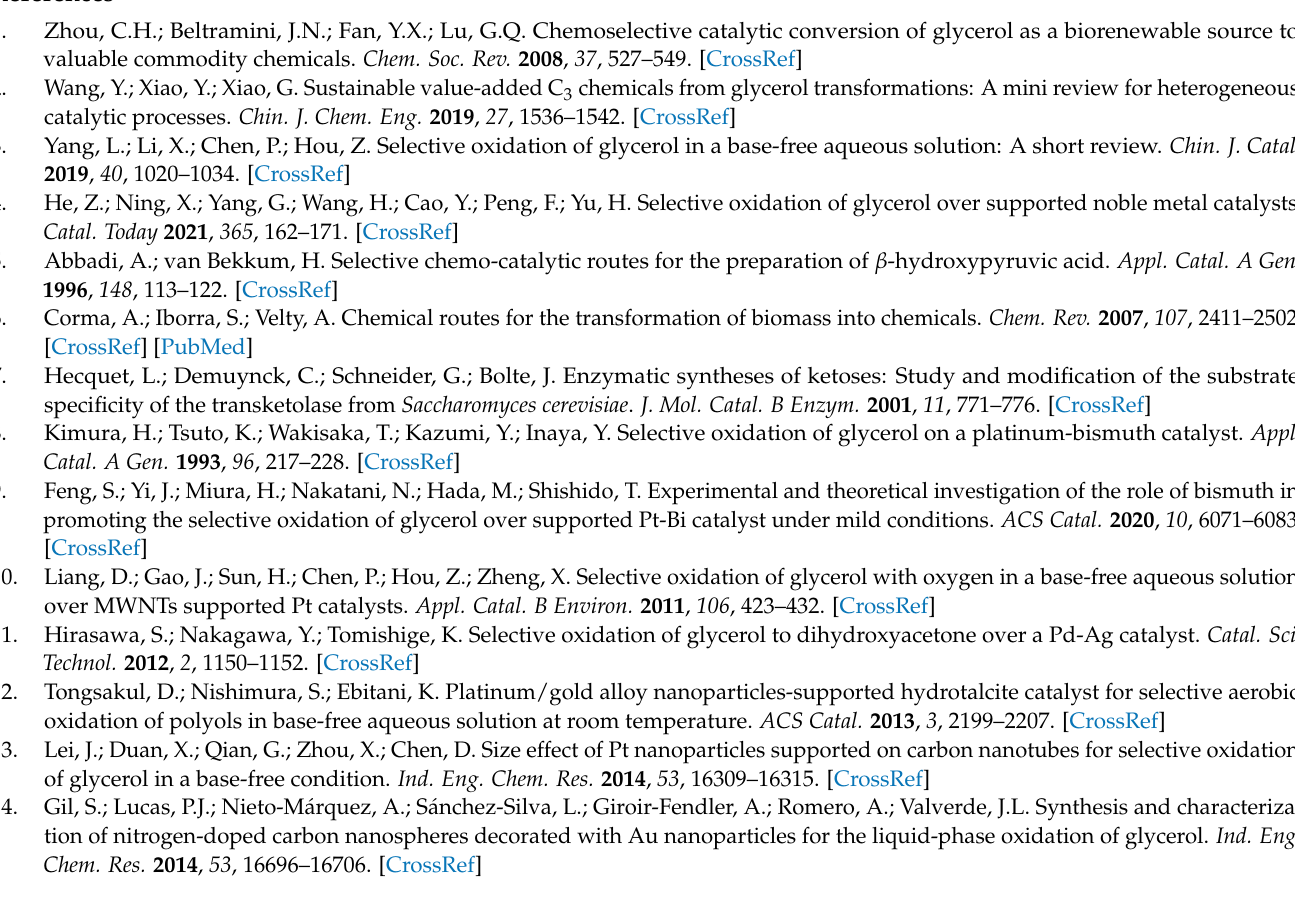
Figure S3: XRD patterns of the used and fresh Pt/CZBi(0.20)Pb(0.05)/SBA